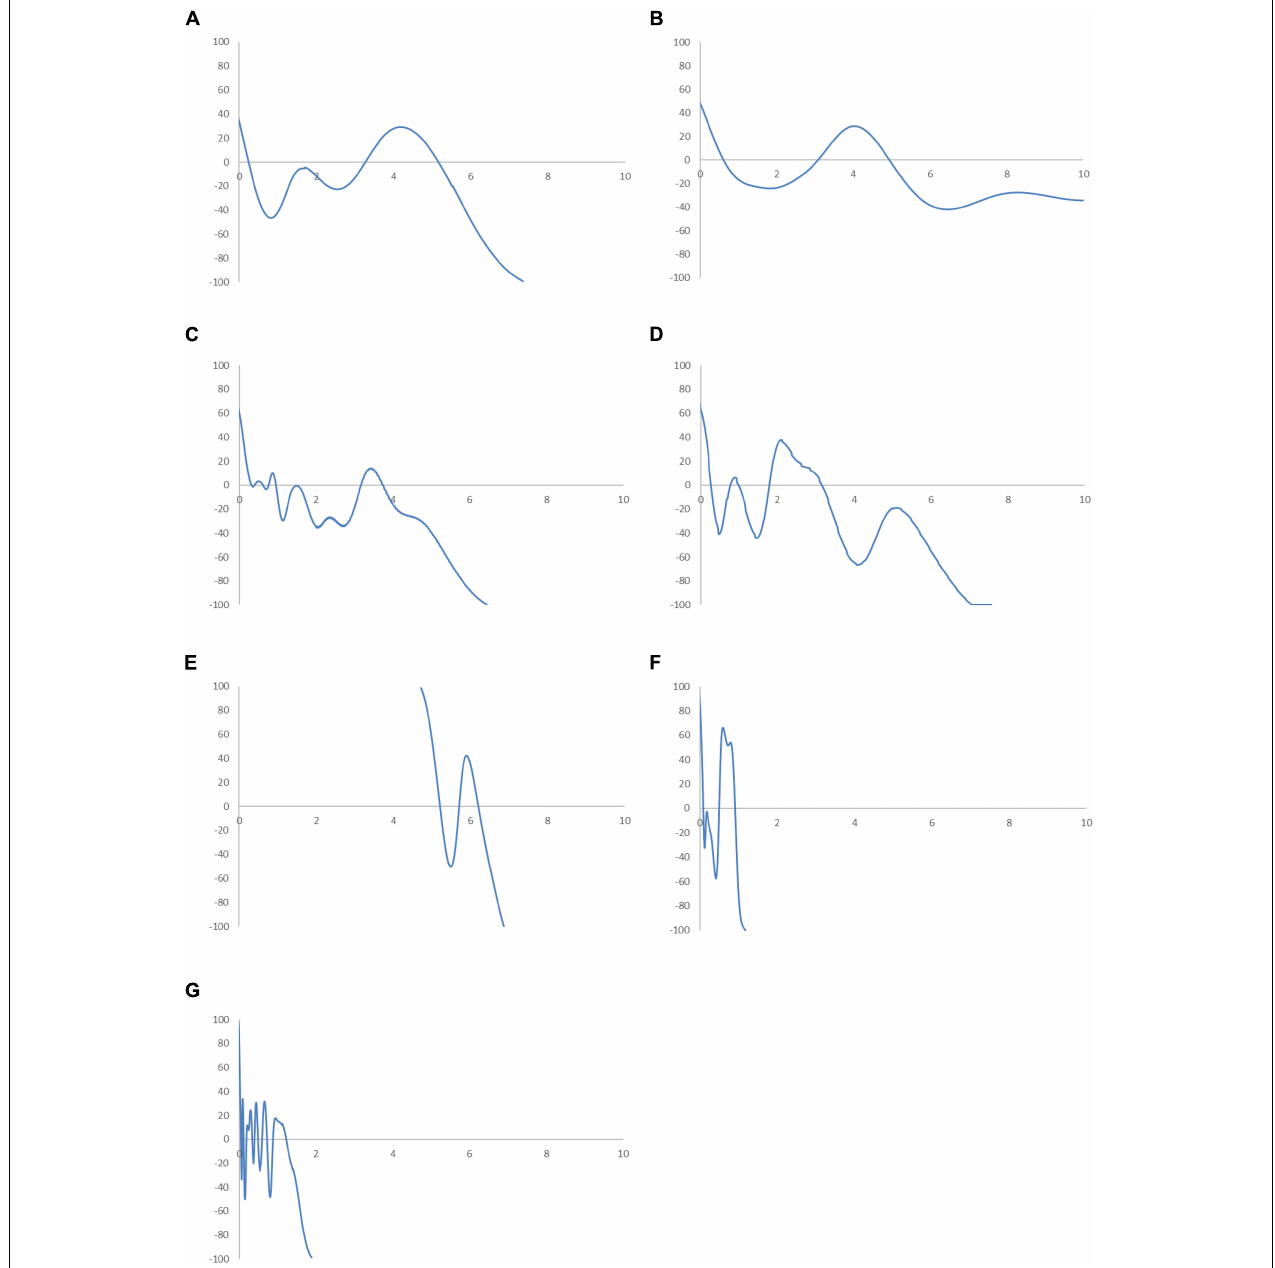
FIGURE 14 | Mobility probability plot (MPP) for the RSVAPC of countries for different geographical regions. Source: Authors’ calculation. N.B. The vertical axis indicates net upward mobility (%) and the horizontal axis indicates RSVAPC values. (A) East Asia and Pacific; (B) Europe and Central Asia; (C) Latin America and the Caribbean; (D) The Middle East and North Africa; (E) North America; (F) South Asia; (G) Sub-Saharan Africa.